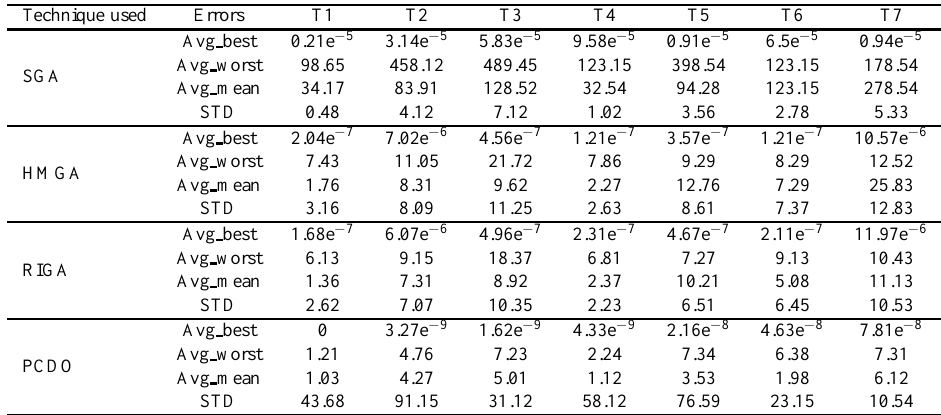
Table 2. Error Values Achieved for Problems F 2